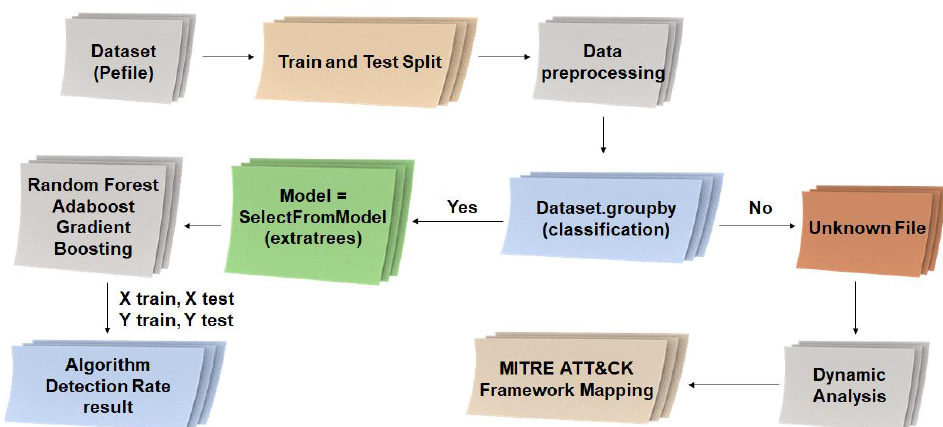
Figure 10. Experimental environment and configuration diagram.